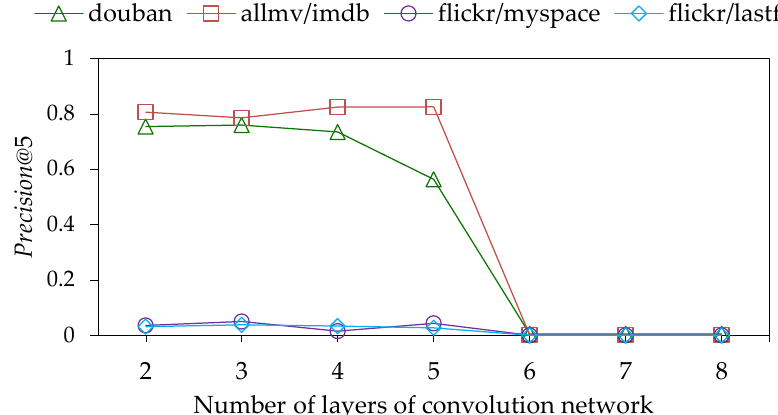
Figure 5. Effect of the number of convolutional layers on Precision @5.